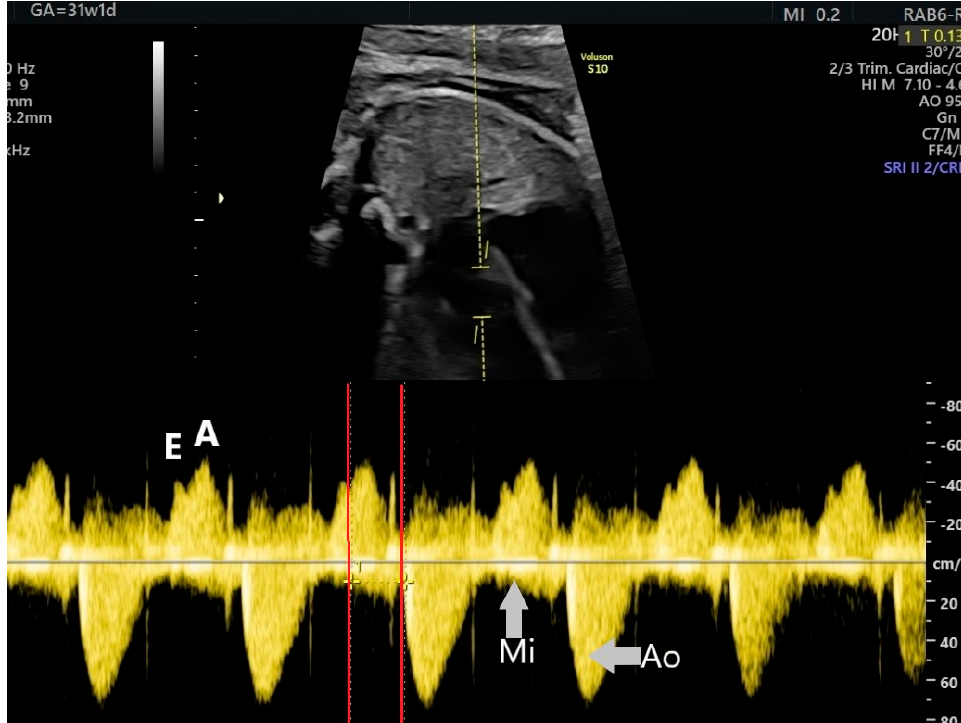
Figure 2. The mechanical PR interval measured with a wide cursor on the mitral and aortic valves. A—the active filling of the ventricles during atrial systole, Ao—aortic flow, E—the passive filling of the atria during generalized diastole, Mi—mitral flow.